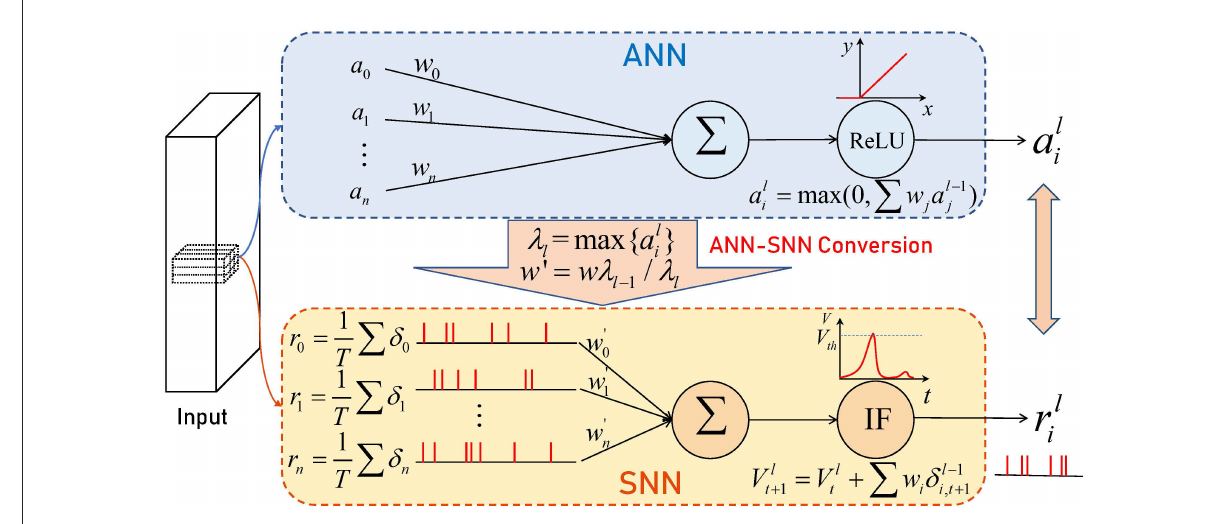
FIGURE1 Illustration of ANN-SNN